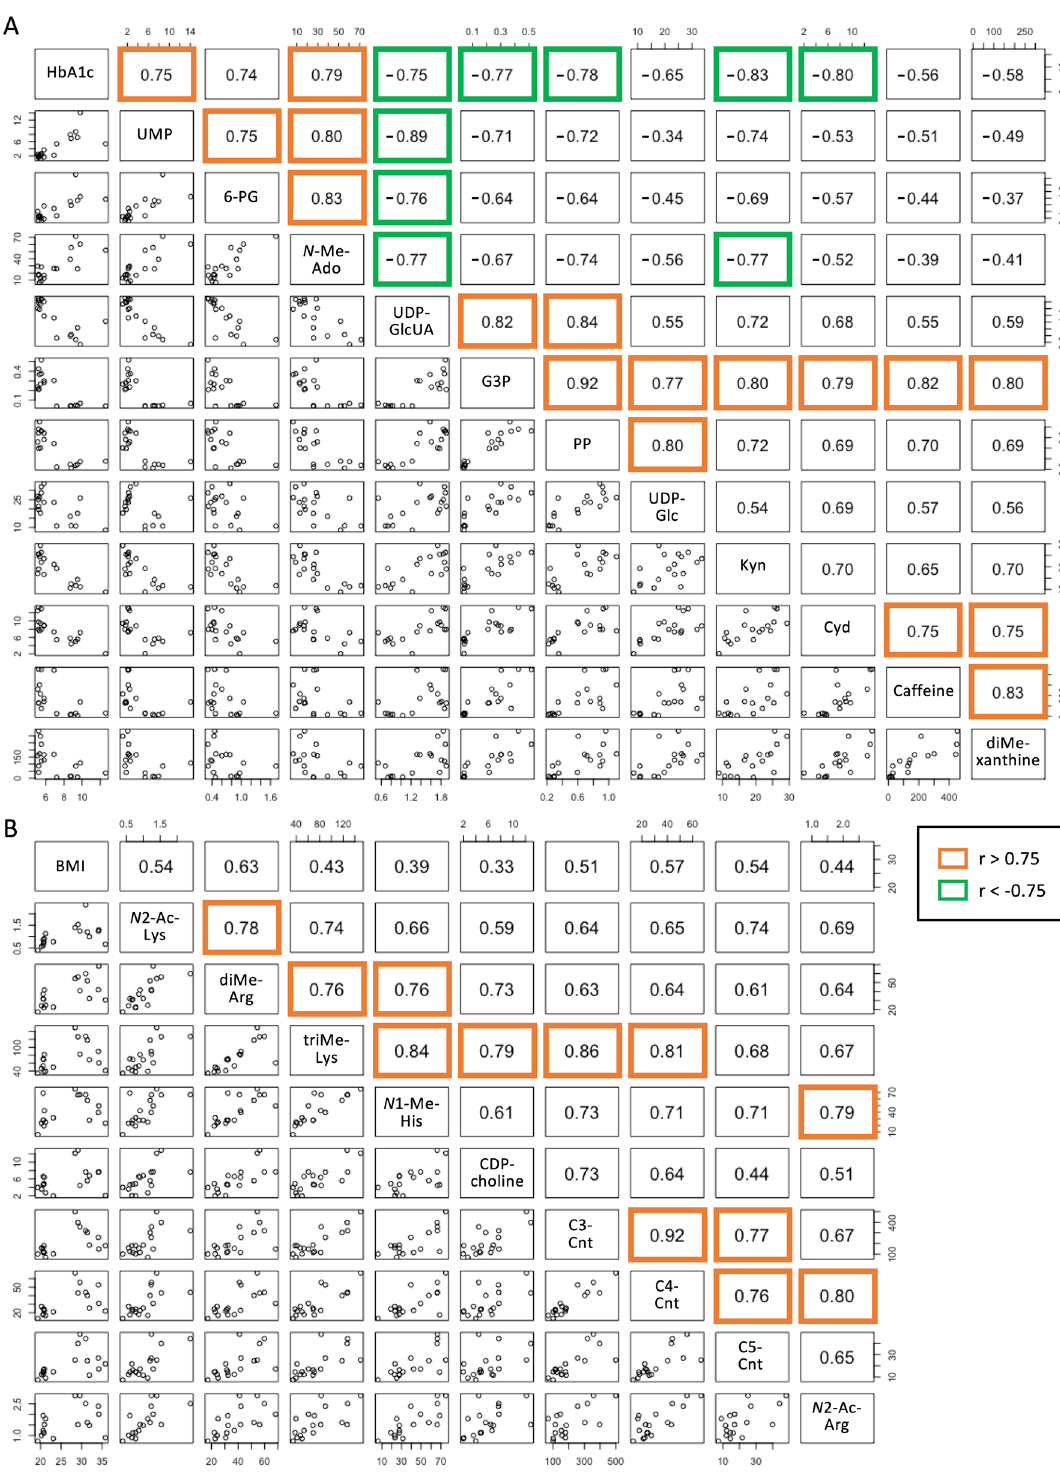
Figure 3. Pearson’s correlation analysis identified strong metabolic relationships. ( A ) Correlation coefficients of T2D markers were calculated. Orange and green boxes indicate positive (r > 0.75) and negative (r < − 0.75) correlations, respectively. 6-PG 6-phosphogluconate, N-Me-Ado N -methyl-adenosine, UDP-GlcUA UDP- glucuronate, G3P glyceraldehyde-3-phosphate, PP pentose-phosphate, UDP-Glc UDP-glucose, Kyn kynurenine, Cyd cytidine, diMe-xanthine dimethyl-xanthine. ( B ) Obesity markers with a correlation of 0.75 or higher are shown. N2-Ac-Lys N 2-acetyl-lysine, diMe-Arg dimethyl-arginine, triMe-Lys trimethyl-lysine, N1-Me-His N1-methyl-histidine, C3-Cnt propionyl-carnitine, C4-Cnt butyryl-carnitine, C5-Cnt valeryl-carnitine, N2-Ac- Arg